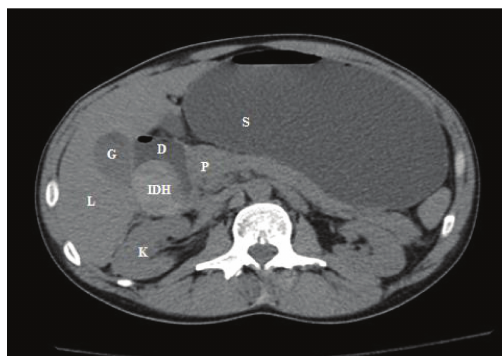
Figure 2: Axial image of noncontrast CT scan of the abdomen at the level of second part of duodenum demonstrates a circumferential hyperdense lesion in the wall of the second part of duodenum with peripancreatic fat stranding. IDH: intramural duodenal hematoma; D: second part of duodenum; P: pancreas; S: stomach; L: liver; K: kidney; G: gall bladder.